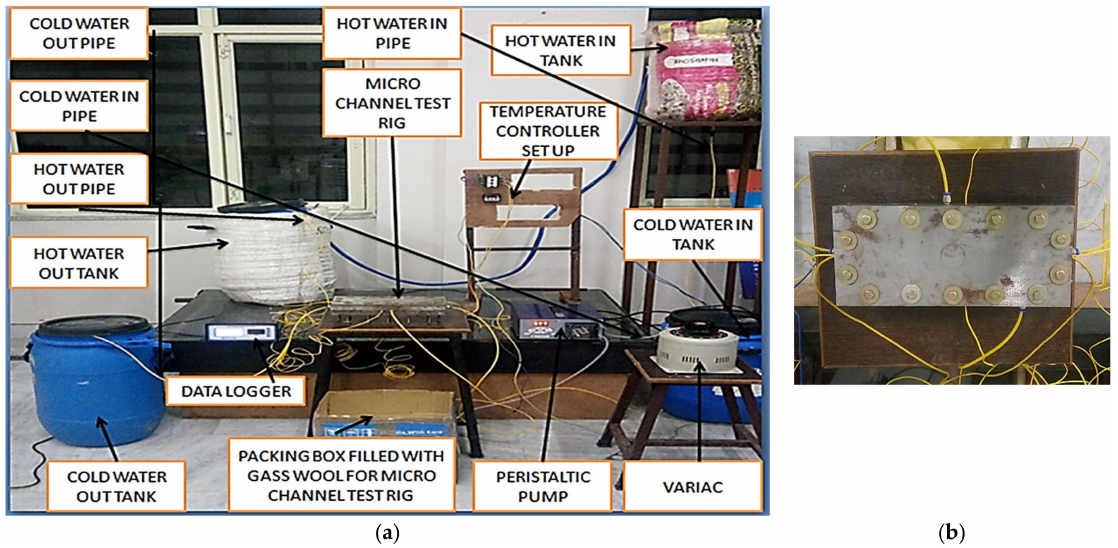
Figure 1. Photographic view of ( a ) the experimental set-up and ( b ) test section.